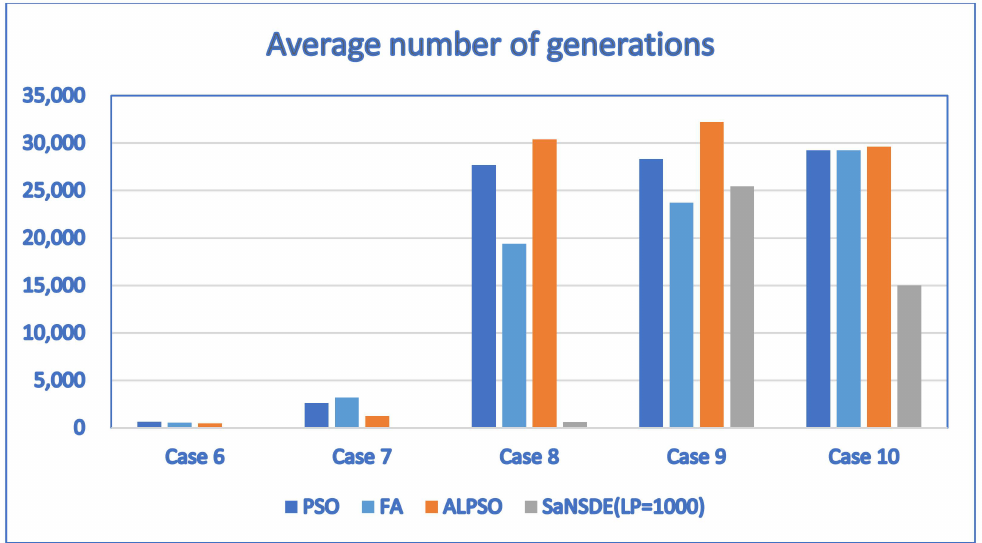
Figure 10. The average number of generations obtained by PSO, FA, ALPSO and SaNSDE with LP = 1000 for Case 6, Case 7, Case 8, Case 9 and Case